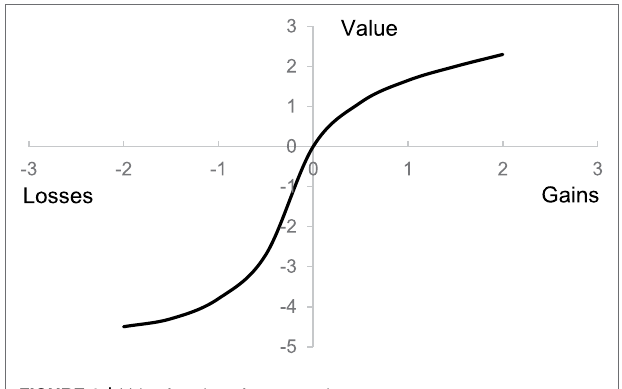
FIGURE 1 | Value function of prospect